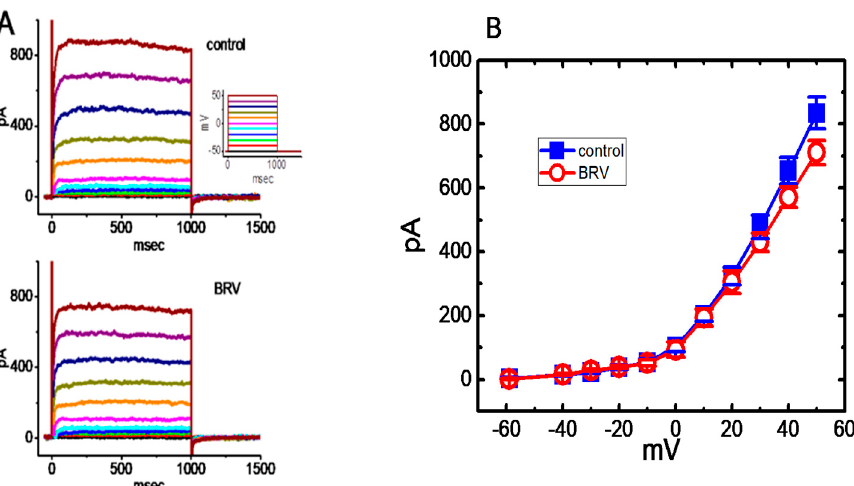
Figure 2. Mild inhibition of BRV on delayed-rectifier K + current ( I K(DR) ) in GH 3 cells. In these experiments, the cells were bathed in Ca 2+ -free Tyrode’s solution containing 1 µM tetrodotoxin and 0.5 mM CdCl 2 , where the recording electrode was filled with a K + -containing solution comprising: K-aspartate 130 mM, KCl 20 mM, MgCl 2 1 mM, Na 2 ATP 3 mM, Na 2 GTP 0.1 mM, EGTA 0.1 mM, and HEPES 5 mM adjusted to pH 7.2 with KOH. ( A ) Representative I K(DR) traces obtained in the absence (upper) and presence of 10 µM BRV. The inset in the upper part of the figure indicates the voltage profile used; ( B ) Comparison of the mean current-voltage (IV) of I K(DR) without ( ○ ) or with the addition ( ■ ) of 10 µM BRV (mean ± SEM; n = 8). The current amplitude was measured at the end of each voltage command pulse. It should be noted that BRV (30 µM) mildly inhibited the I K(DR) amplitude at +50 mV.